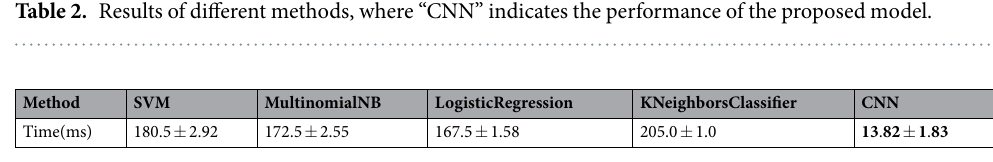
Table 3. The average prediction time of different methods for each EMR in test set, where “CNN” indicates the performance of the proposed